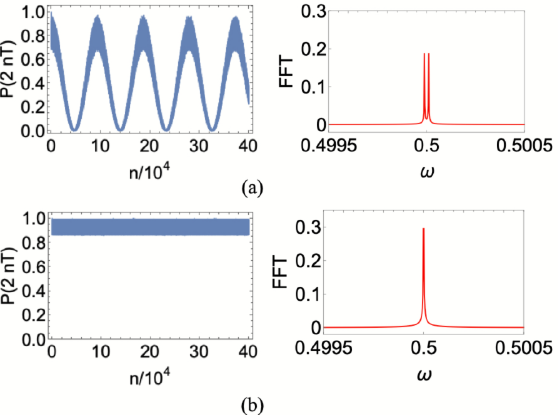
, P ( 2 nT ) oscillates when n > n ∗ 2